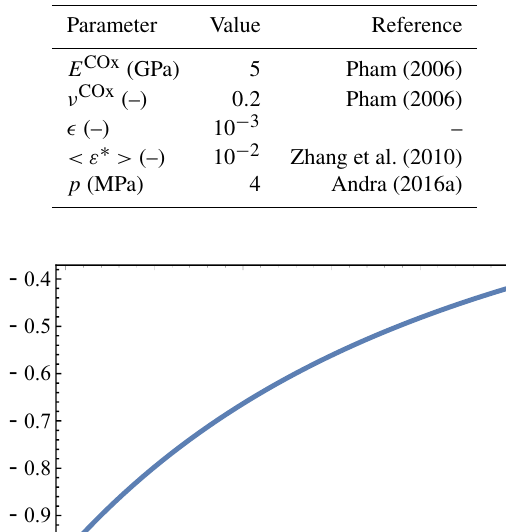
Table 1. Parameters used for the numerical results.